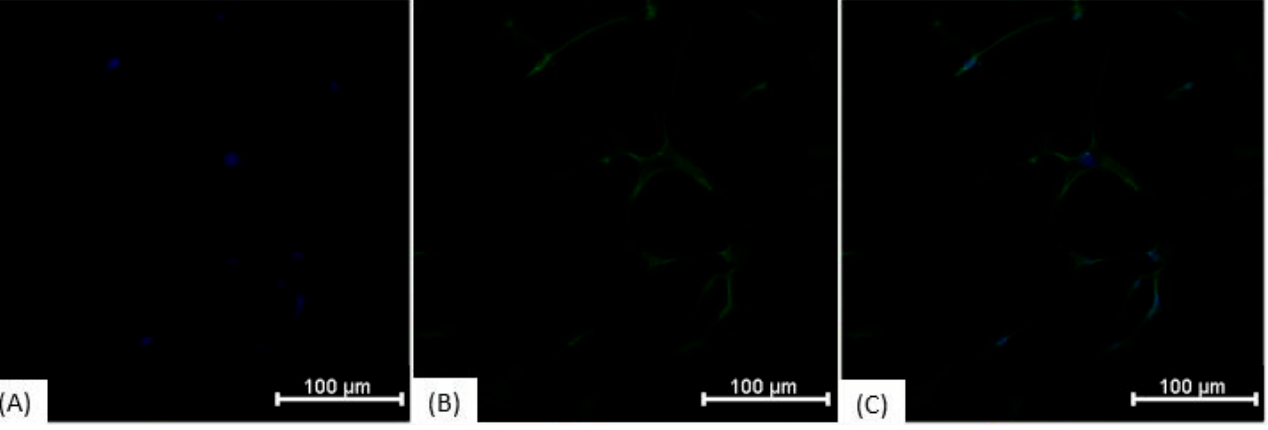
Figure 6. Immunocytochemistry of neurosphere-derived NPs cultivated on NFBX membrane and dissociated on polysty- rene plates. ( A ) NPs cultured on NFBX membrane marking the nucleus with Hoechst (blue); ( B ) Anti-AMOT antibody with cytoplasmic labeling (FITC—green); ( C ) Overlapping images A and B; ( D ) Hoechst (blue) marking the nucleus of the cells; ( E ) Anti-YAP1 antibody with cytoplasmic labeling (Cy5—red); ( F ) Overlapping images D and E images. The images were taken with In Cell Analyzer 2000, GE (20×). Scale bars, 100 µm. NFBX, natural functional biopolymer matrix; NPs, neural precursors. 3.4. Qualitative Reverse Transcriptio–-Polymeresae Chain Reaction (RT-PCR) The results of the RT-PCR analysis demonstrated that neurosphere-derived NPs and undifferentiated ADMSCs have a very similar gene expression, and both cells expressed neuronal and pluripotency markers (Figures 7–10). However, there was a difference in the expression of the MAPT gene, which was present in NPs but not in ADMSCs (Figures 9,10). This gene is present in the axons of neurons and could suggest an increased neu- ronal commitment of NPs. The S100 and ASCL1 genes were not expressed by any of the cells (Figures 7,8). Future studies will be needed to better understand the differences in gene expression between ADMSCs and NPs, using quantitative techniques such as real-time quantitative reverse transcription PCR (qRT-PCR).